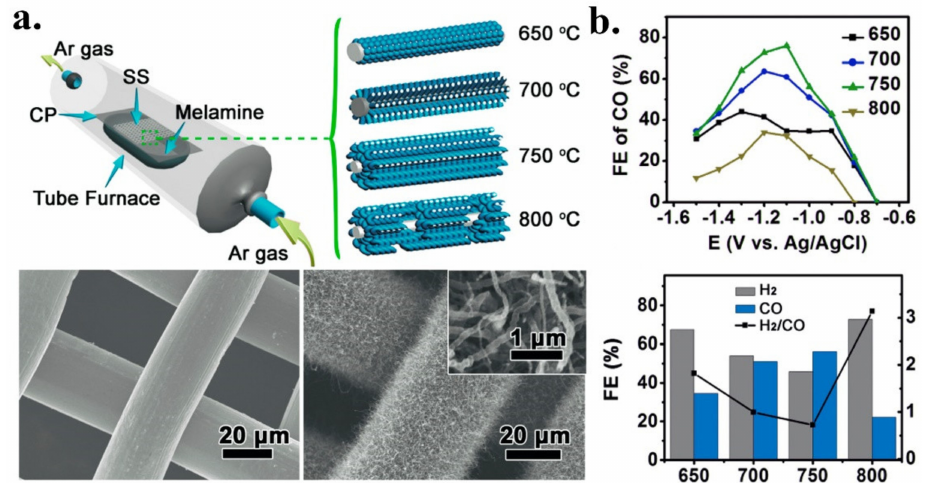
Figure 5. ( a ) Scheme of the synthesis of integrated 3D electrodes by the direct grown of N-doped carbon nanotubes on a stainless-steel mesh and SEM images. ( b ) Faradaic efficiencies for CO at various applied potentials (up) and Faradaic efficiency and molar ratio of H 2 /CO of different samples at − 1.0 V vs. Ag/AgCl (down). Adapted from